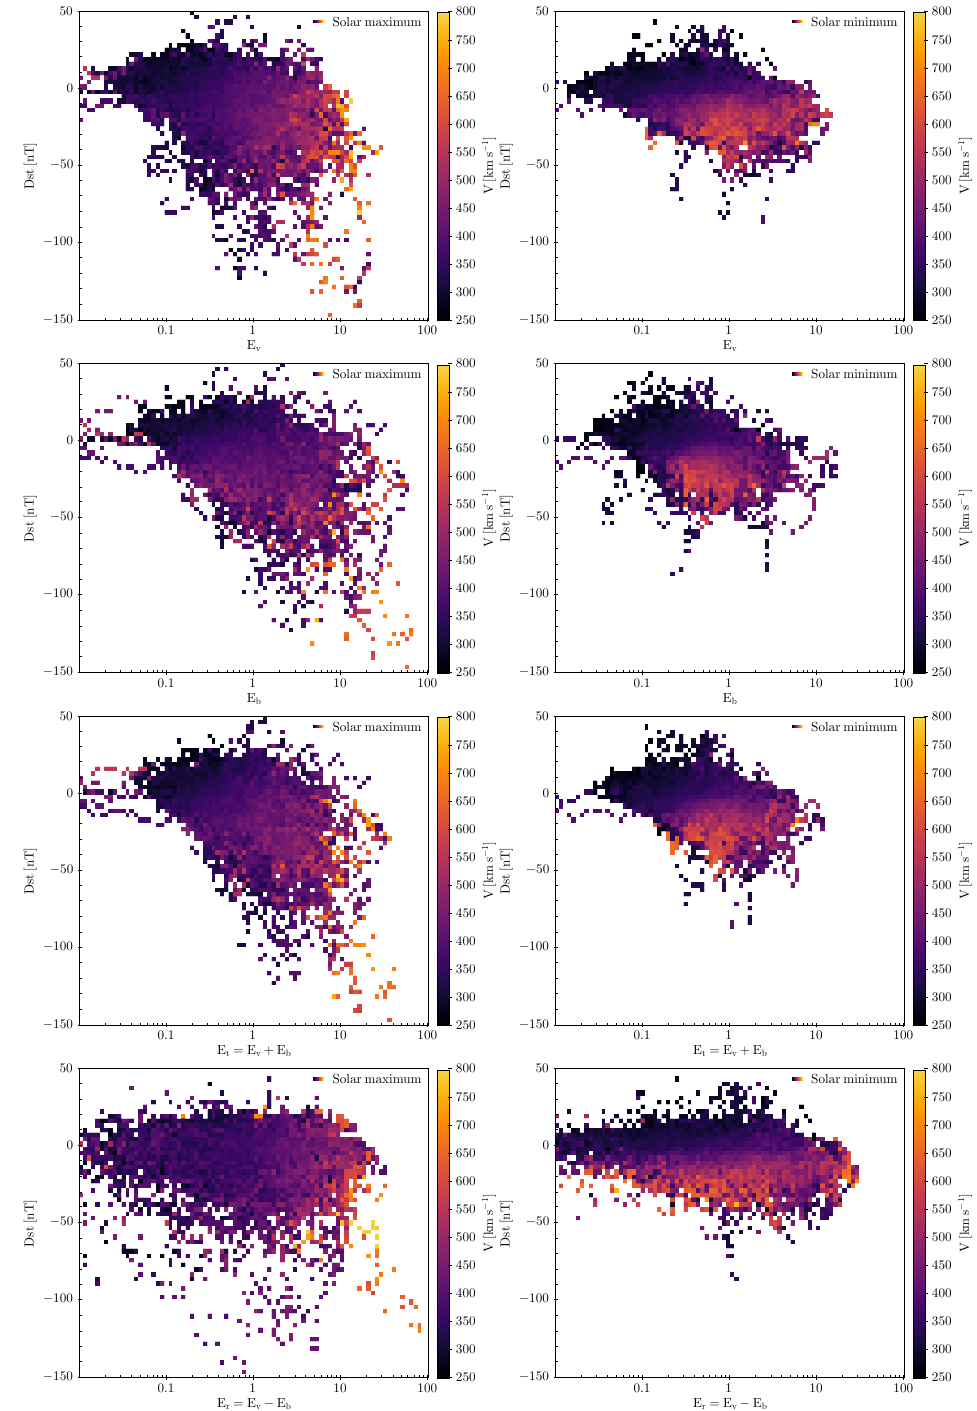
Figure 4. 2D histogram of the median value of the solar wind bulk speed V in the E − Dst plane observed during the maximum ( left panels ) and minimum ( right panels ) activity periods. First row: kinetic energy E v , second row: magnetic energy E b , third row: total energy E t , and fourth row: residual energy E r = E v − E b